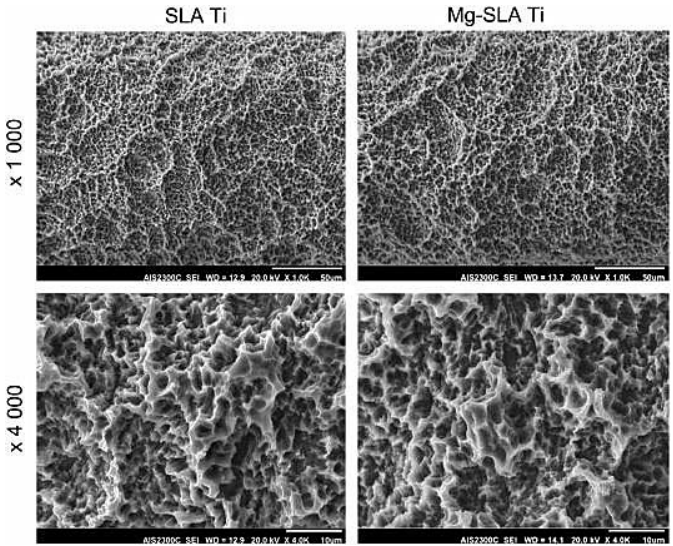
Figure 11. SEM micrograph of SLA-treated Ti samples and Mg-ion implanted SLA-Ti with 1000× and 4000× magnification [119] (reproduced with permission number: 5071100309175, Elsevier).